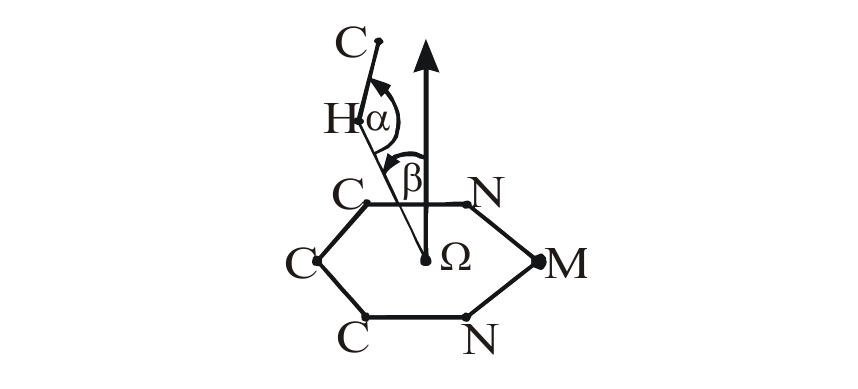
Figure 1. Geometrical parameters for C − H ··· π interaction with chelate ring of porphyrinato ligand. Results and